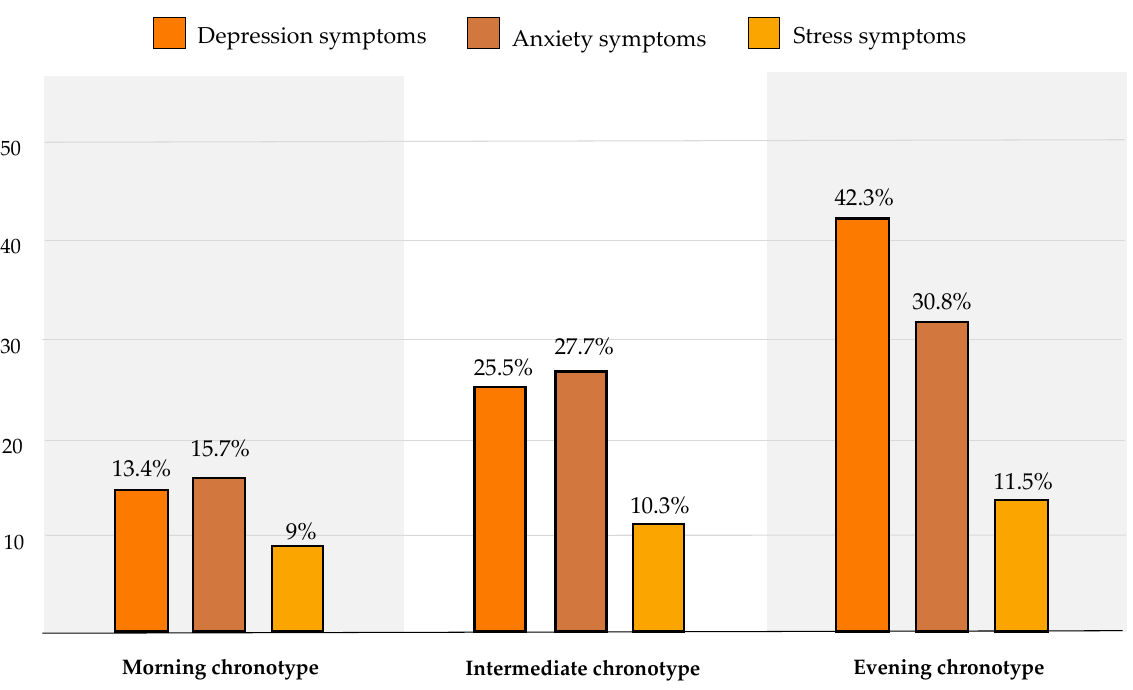
Figure 3. Percentage of participants reporting symptoms of depression, anxiety, and stress according to individual